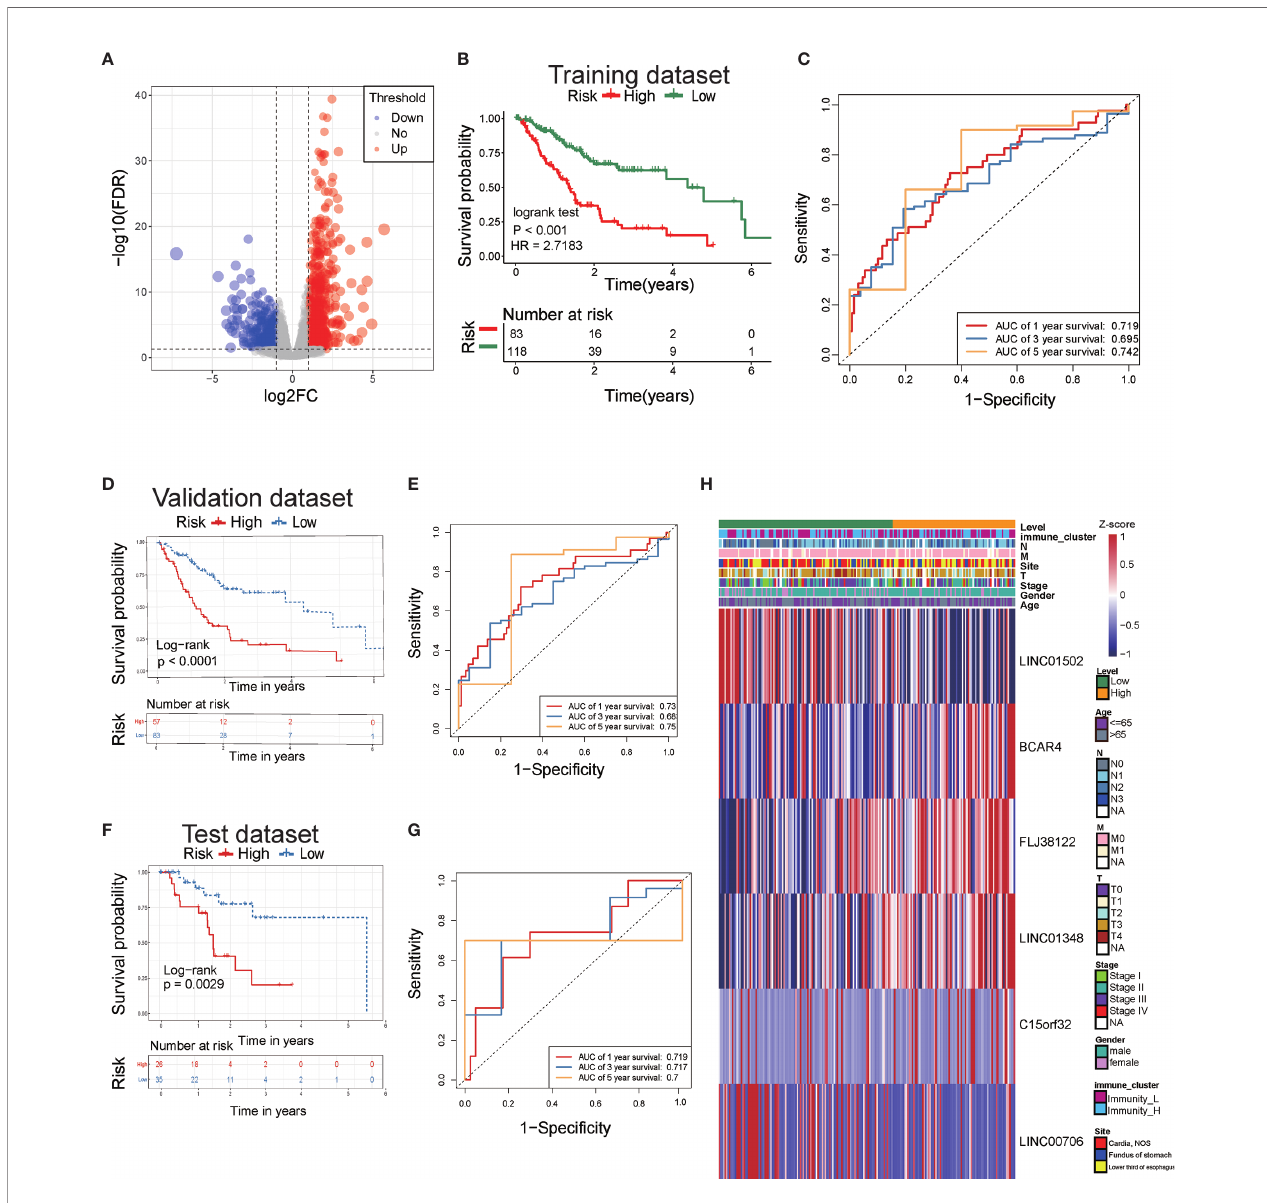
FIGURE 5 | Analysis of differentially expressed lncRNAs and identi fi cation of immune-related lncRNA prognostic signature for AEG. (A) The volcano plot showed that 1016 lncRNAs were up-regulated and 454 down-regulated between the two immune in fi ltration subtypes. Each red dot showed an up-regulated lncRNA, and each blue dot shows a downregulated lncRNA (|Log2 Fold Chage| > 1 and FDR < 0.05). (B) The multiple stepwise regression analyses identi fi ed six lncRNAs correlated with prognostics. Patients in the high-risk group (red) exhibited worse overall survival (OS) than those in the low-risk group (green). (C) The receiver operator characteristic (ROC) curves to predict the sensitivity and speci fi city of 1-, 3-, and 5- years survival according to the 6-lncRNA signature-derived risk scores. (D) Kaplan – Meier analysis of the high versus low immune risk subgroup in validation dataset. (E) ROC curves to predict the sensitivity and speci fi city of 1-, 3-, and 5- years survival in validation dataset. (F) Kaplan – Meier analysis of the high versus low immune risk subgroup in test dataset. (G) ROC curves to predict the sensitivity and speci fi city of 1, 3, and 5 years survival in test dataset. (H) The expression of six lncRNAs in AEG